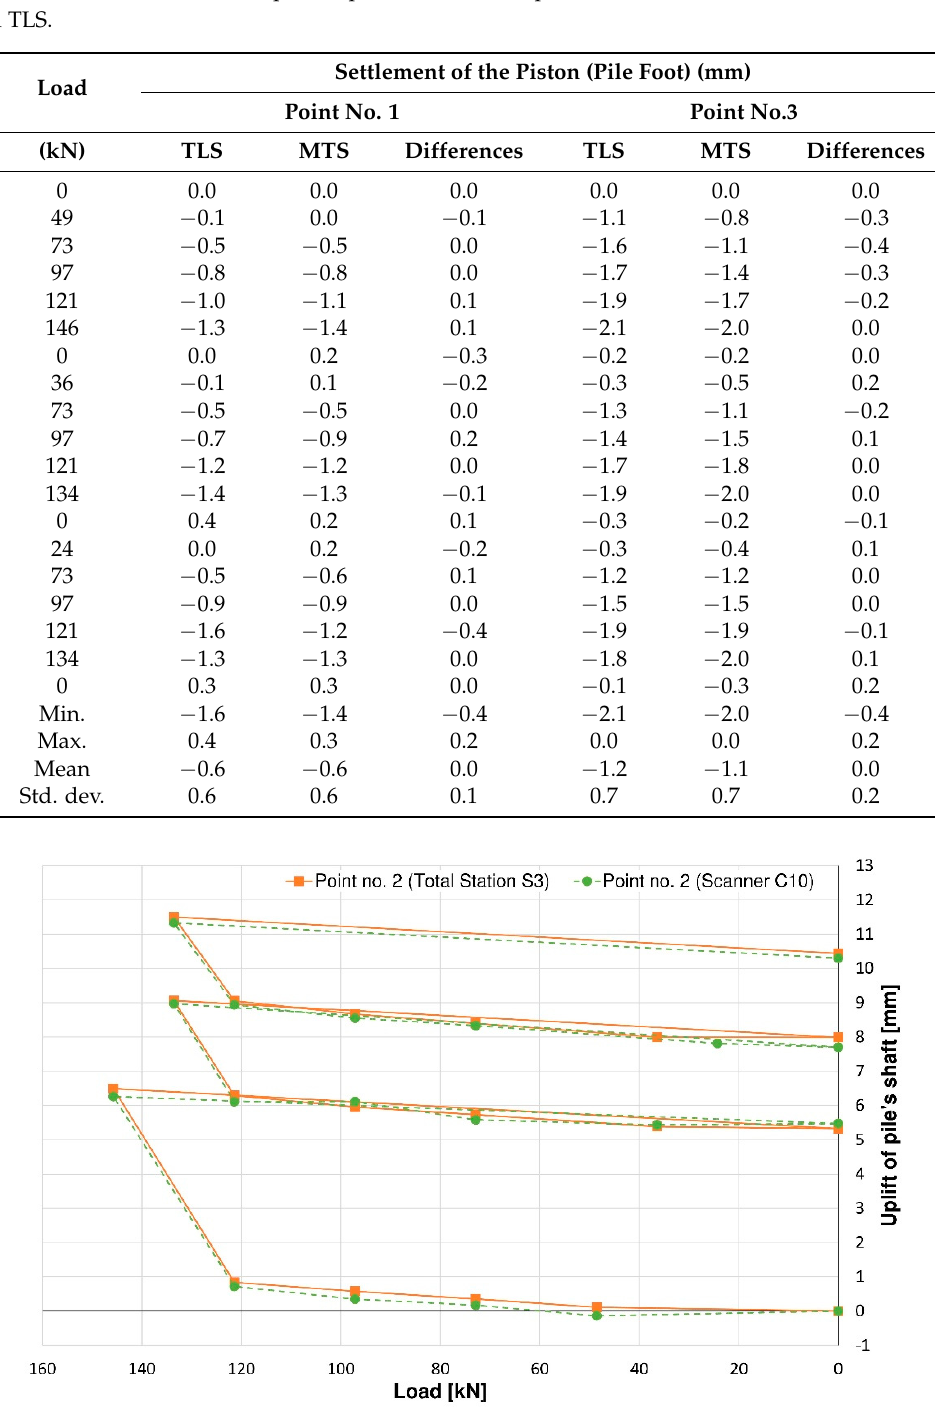
Table 5. The settlements of the piston (pile foot) for checkpoints no. 1 and no. 3 calculated from MTS and TLS.